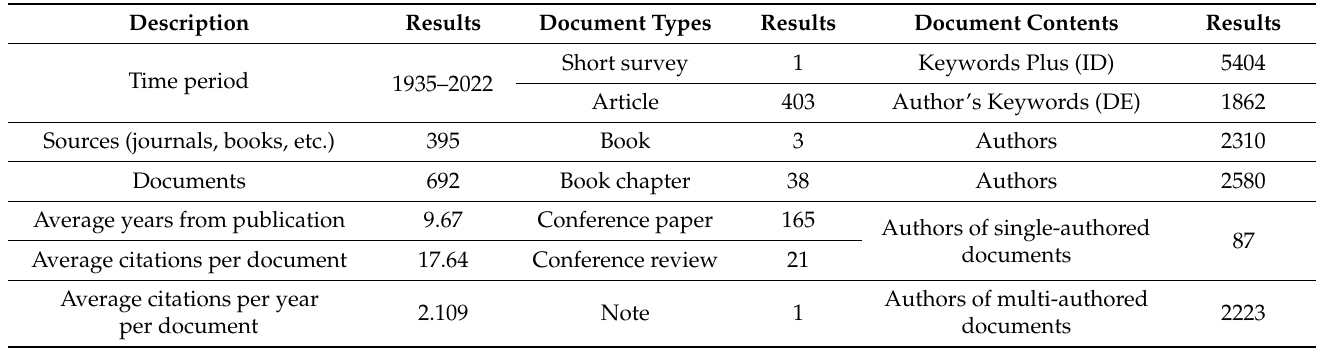
y = 2E − 50e 0.0582x R² = 0.6549